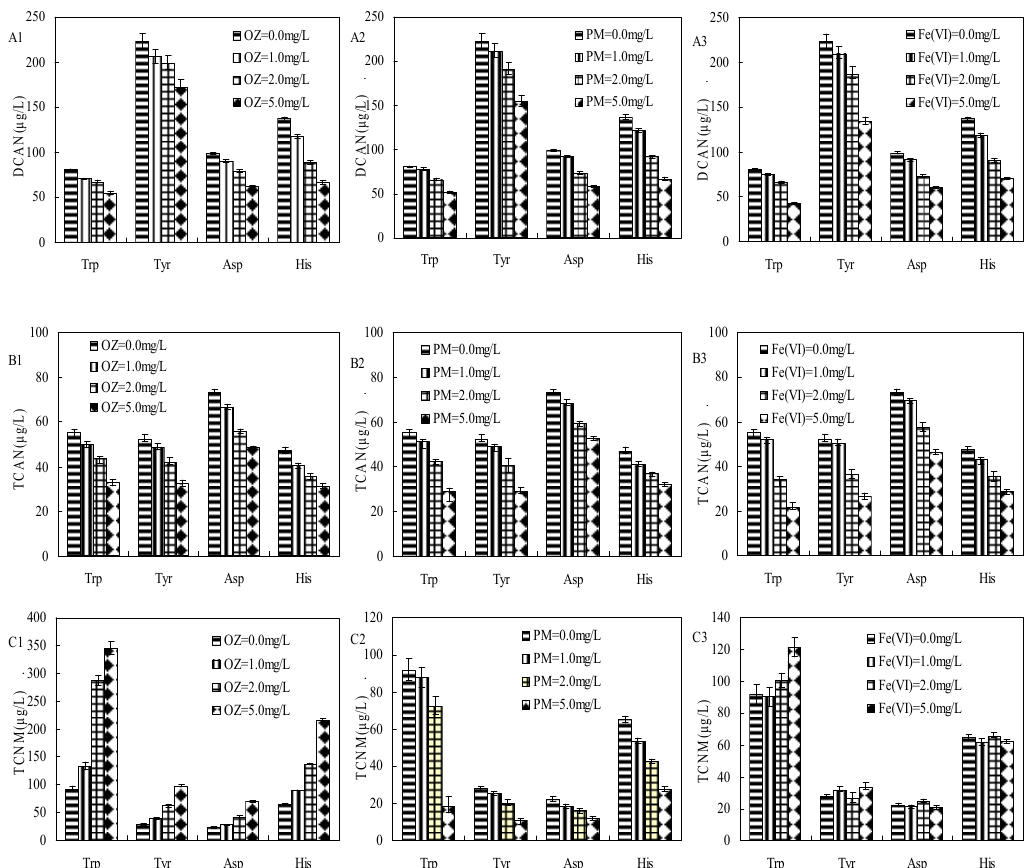
Figure 2. Formation of dichloroacetonitrile (DCAN) ( A1 – A3 ), trichloroacetonitrile (TCAN) ( B1 – B3 ), and TCNM ( C1 – C3 ) during pre-oxidation (ozone (OZ), permanganate (PM), and Fe(VI)) of Trp, Tyr, Asp, and His subsequent chlorination (Trp = 0.1 mM, Tyr = 0.1 mM, Asp = 0.1 mM, His = 0.1 mM, Cl2 = 3 mM, pre-oxidant contact time = 0.5 h, chlorine contact time = 24 h, pH = 7 ± 0.2, and temperature = 22 ± 1 °C). The bars represent the standard deviation of replicate measurements ( n = 3).